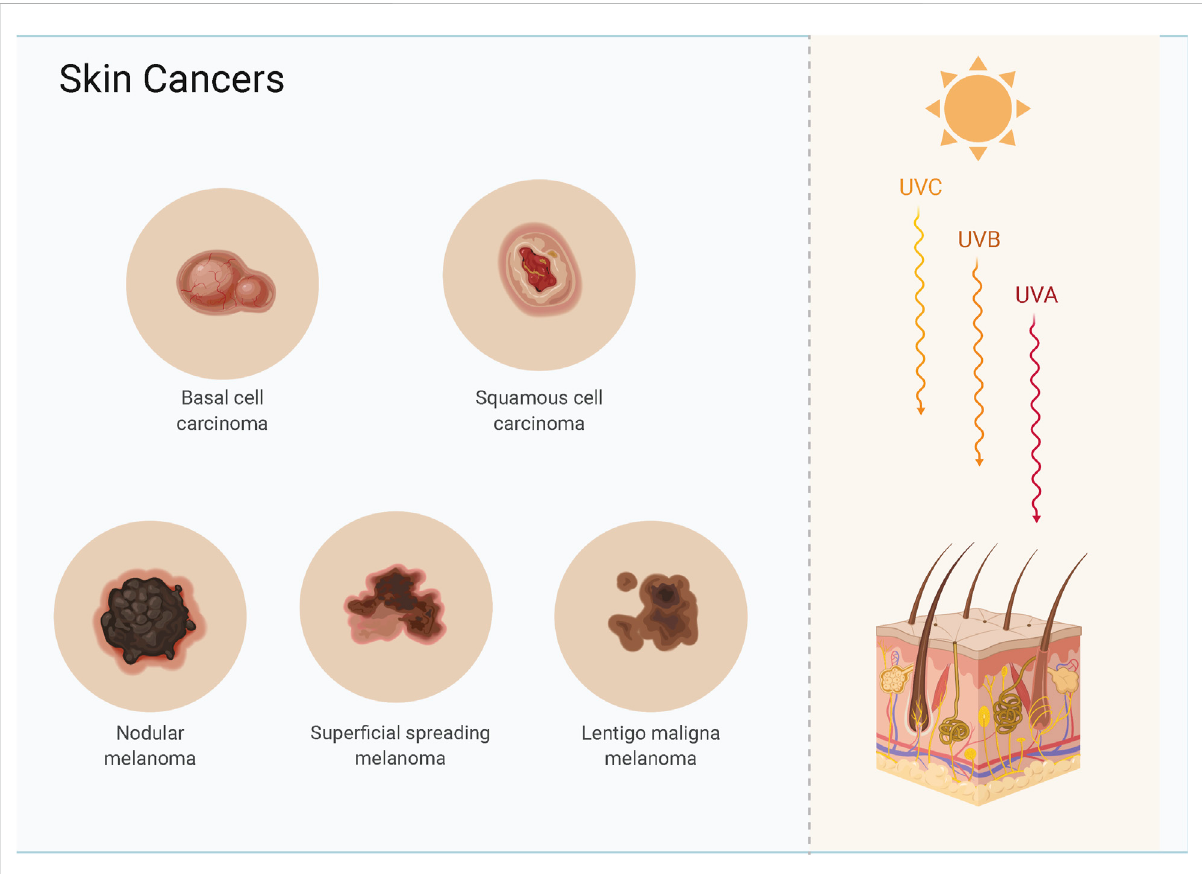
FIGURE 1 Skin cancers include basal cell carcinoma, cutaneous squamous cell carcinoma and